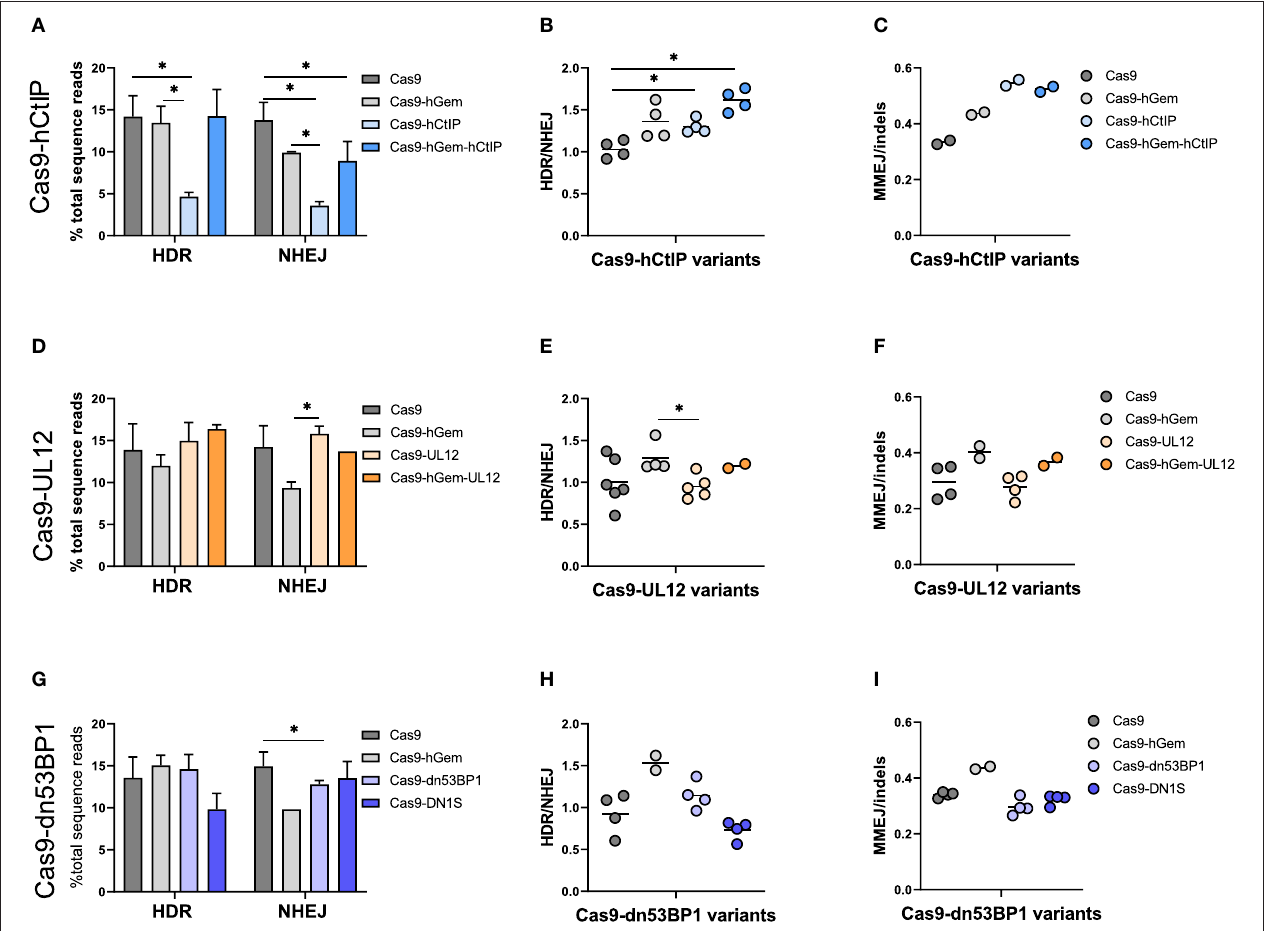
FIGURE 6 | Cas9 variant gene editing of the β -globin locus with an AAV6 donor reveals distinctive DNA repair outcomes in HSPCs. CD34 + HSPCs edited with Cas9 variants (3 pmol Cas9 mRNA + 120 pmol IVT sgRNA) and an AAV6 donor (MOI 2e4). Editing outcomes were measured by MiSeq HTS 4 days post-electroporation. Cas9 and Cas9-hGem were used as controls. (A–C) Gene editing outcomes with Cas9-hCtIP variants. (A) HDR and NHEJ. n = 4 biological replicates). Error bars, mean ± SD. (B) HDR/NHEJ. n = 4 biological replicates Center line represents mean (C) MMEJ/indels. n = 2 biological replicates. Center line represents mean. (D–F) Gene editing outcomes with Cas9-UL12 variants. (D) HDR and NHEJ. n = 2–6 biological replicates. Error bars, mean ± SD. (E) HDR/NHEJ. n = 2–6 biological replicates Center line represents mean (F) MMEJ/indels. n = 2–4 biological replicates. Center line represents mean. (G–I) Gene editing outcomes with Cas9-dn53BP1 variants. (G) HDR and NHEJ. n = 2–4 biological replicates. Error bars, mean ± SD. (H) HDR/NHEJ, n = 2–4 biological replicates. Center line represents mean (I) MMEJ/indels. n = 2–4 biological replicates. Center line represents mean. Differences are not significant if not specified, * p < 0.05, based on Wilcoxon rank sum